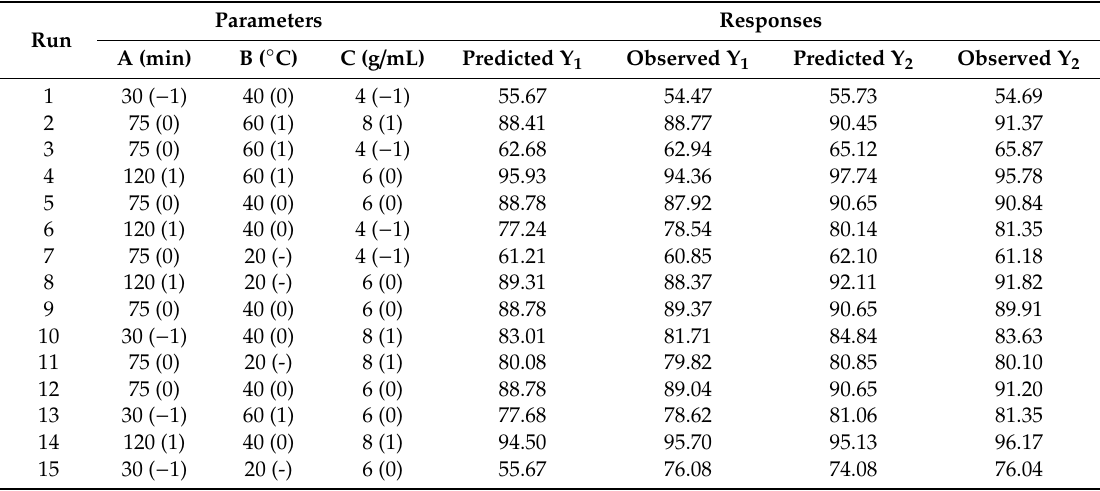
Table 1. Extraction e ffi ciencies of D and DA: design arrangements and responses.